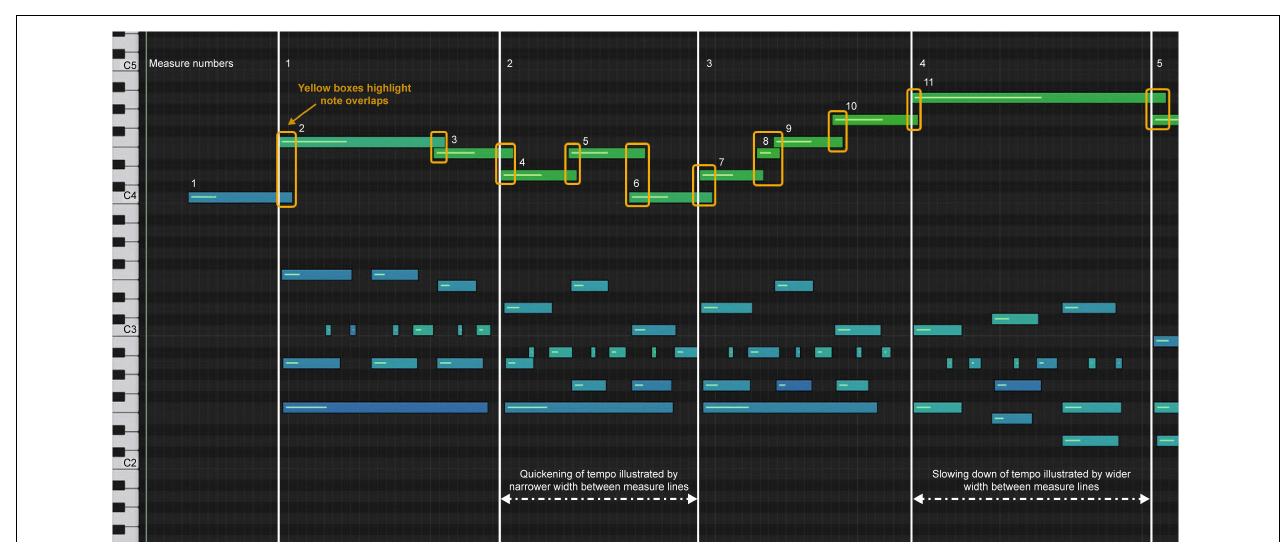
FIGURE 5 | Sonification score, model B, measures